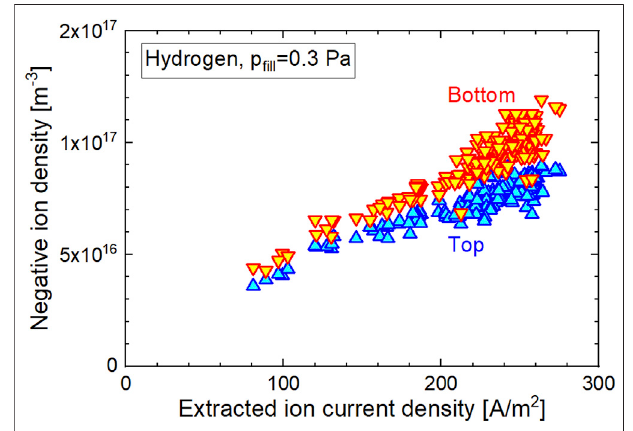
FIGURE 5 | Negative ion density measured with CRDS at the test facility ELISEcorrelatedwiththeextractednegativeiondensityatdifferentappliedRF powers and extraction voltages for caesiated hydrogen discharges. Two lines of sight are used: one above the upper grid segment (Top) and one above the lower grid segment (Bottom)